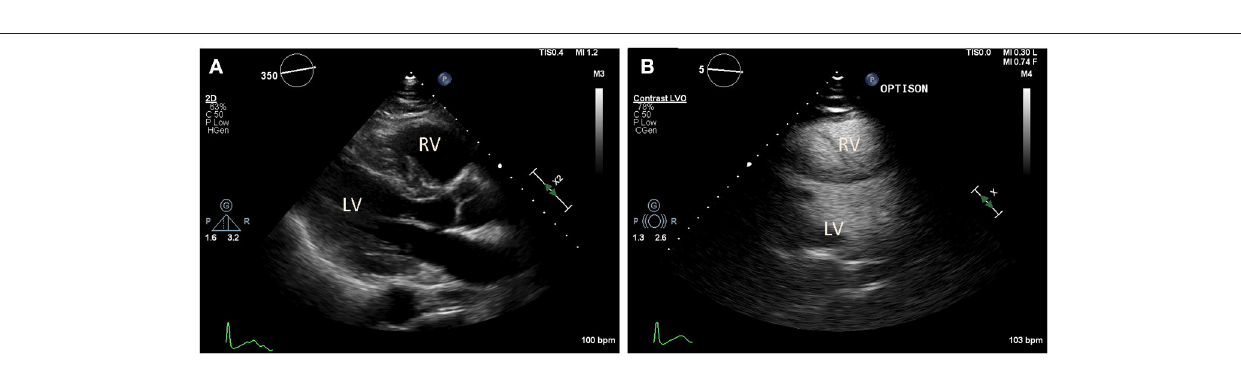
disease, hypertension, and chronic cardiomyopathy (41,